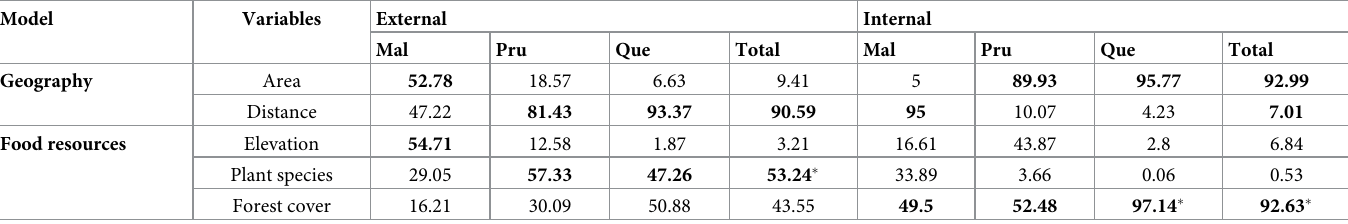
Table 3. Summary of hierarchical partitioning for external and internal feeding guilds using geography and habitat diversity and plant resources.